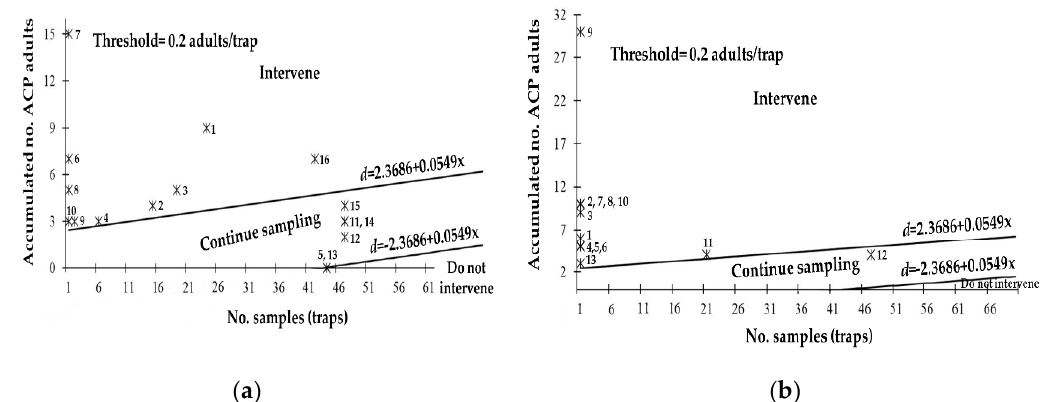
Figure 5. Stop lines for decision making in the SPRT sequential sampling for the Asian citrus psyllid in Nuevo Le ó n state, Mex. ( a ) Citrus grove 1. ( b ) Citrus grove 2. 2020 sampling dates: (1) X-27, (2) X-31; (3) XI-14, (4) XI-28; (5) XII-12, (6) XII-26. 2021 sampling dates: (7) I-9, (8) I-23; (9) II-6, (10) II-20; (11) III-6, (12) III-20; (13) IV-3, (14) IV-17; (15) V-5, (16) V-15. Number in the symbol indicates the sampling date. Symbols represent the number of traps at the accumulated number of ACP adults to reach a decision.